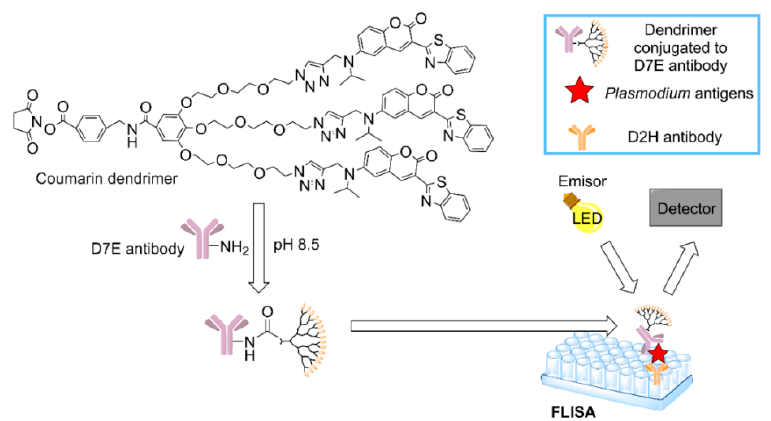
Figure 7. Mechanism to detect malaria antigens using the coumarin-derived dendrimer-based fluorescence-linked immunosorbent assay (FLISA) [145].